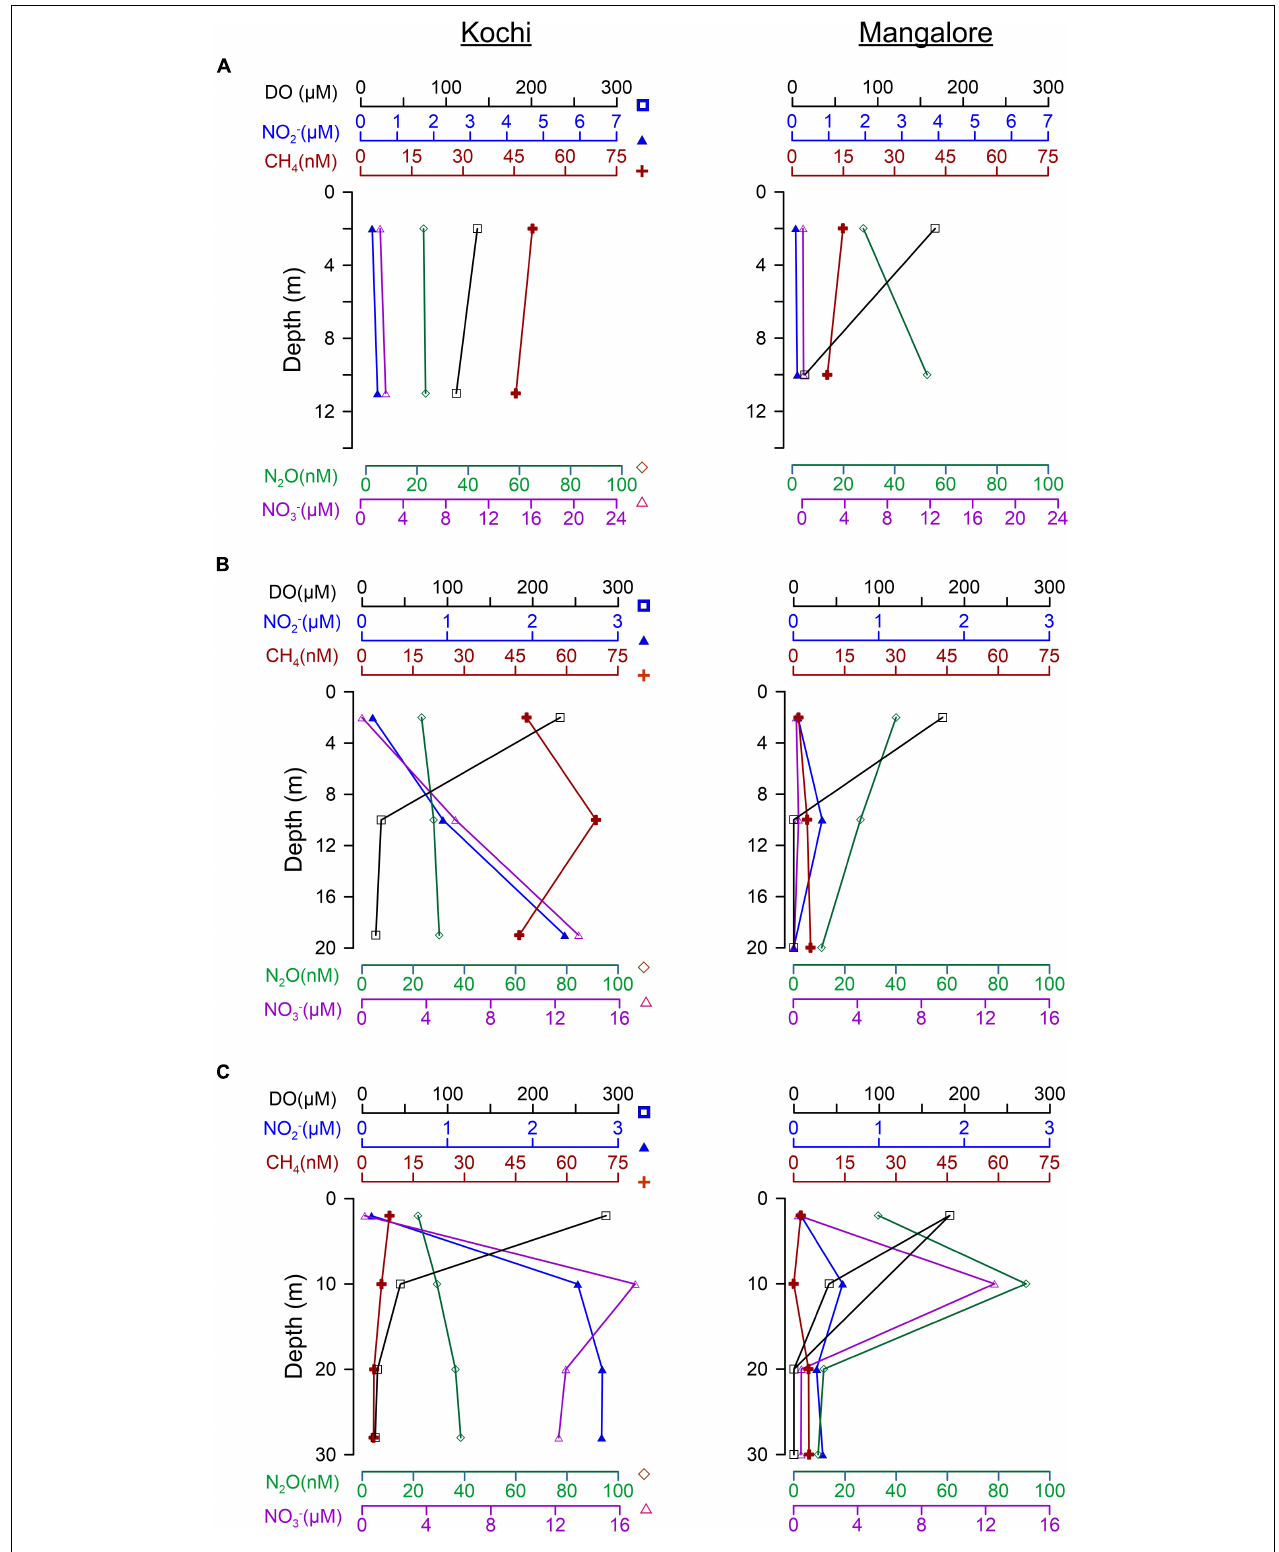
FIGURE 6 | Comparison of vertical profiles for DO, NO 3 − , NO 2 − , N 2 O, and CH 4 between Kochi and Mangalore for 13, 20, and 30 m stations ( A–C , respectively) during September 2012.